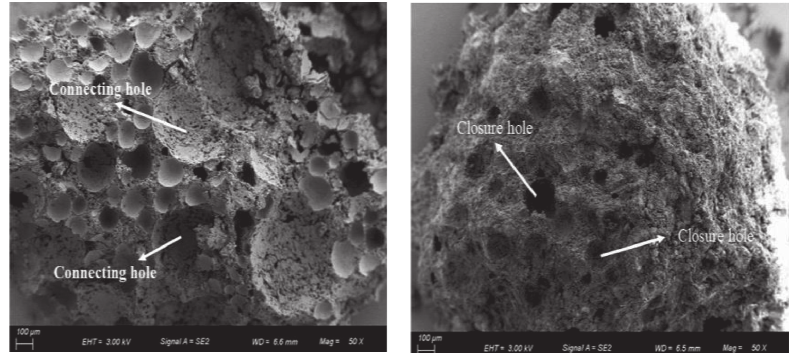
Figure 8: Photograph of 28d hydration of the specimen when scanned by electron microscope at